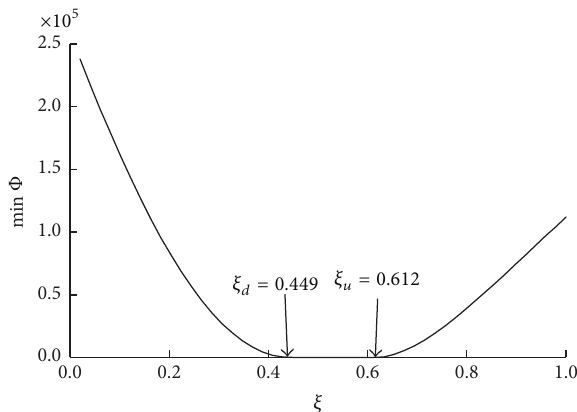
Figure 3: The minimum value of the function Φ